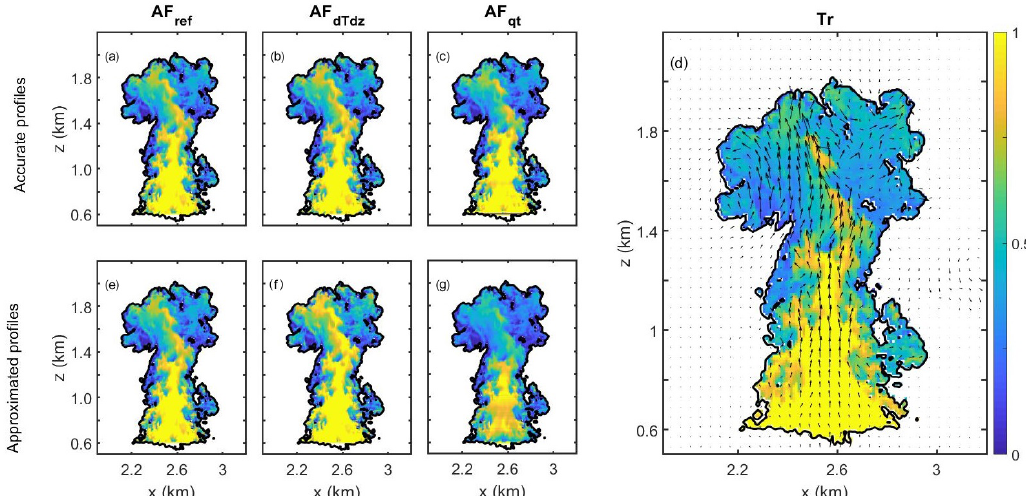
Figure 1. Cross sections of the tracer and the three AF methods presented for a cloud with a 500cm − 3 aerosol concentration at the time of its maximal top height. The AFs in the upper row were calculated using accurate adiabatic profiles of T and q v . Profiles in the bottom row were approximated using high updrafts. (a) The method for calculating AF used as a reference (AF ref ) by solving Eq. (6). (b) Same as (a) for AF d T d z using Eq. (8). (c) Same as (a) for AF qt using Eq. (7). (d) Normalized concentration of the sub-cloud layer tracer (Tr). (e) Same as (a) for approximated profiles. (f) Same as (b) using approximated profiles. (g) Same as (c) using approximated